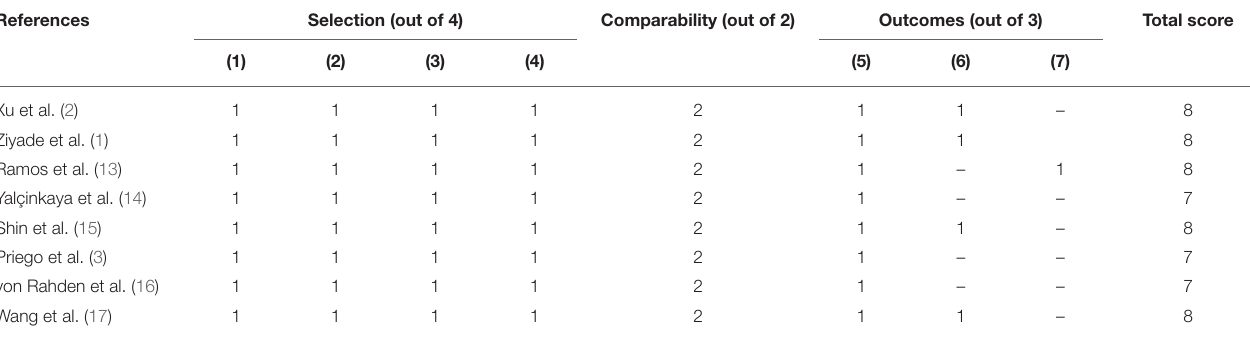
TABLE 1 | Quality assessment of the non-randomized studies using the Newcastle-Ottawa